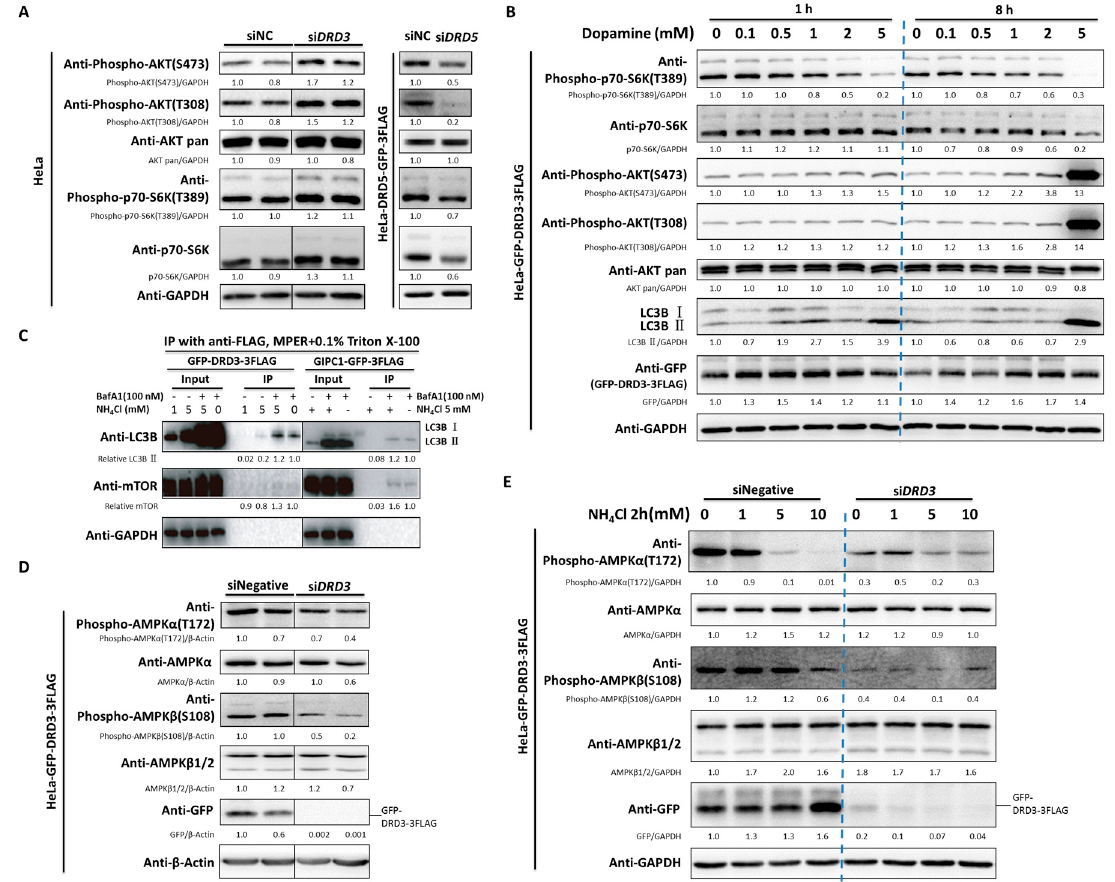
Figure 5. AKT (protein kinase B)-mTOR (mechanistic target of rapamycin) and AMPK (AMP-activated protein kinase) pathways are involved in DRD3-regulated autophagy. ( A ) DRD3 or DRD5 RNAi in HeLa wild type or HeLa cells stably expressing DRD5-GFP-3FLAG. ( B ) HeLa cells stably expressing GFP-DRD3-3FLAG were treated with increasing concentrations of dopamine for 1 h or 8 h. ( C ) Co-Immunoprecipitation using anti-FLAG in HeLa cells stably expressing GFP-DRD3-3FLAG or GIPC1-GFP-3FLAG treated with Baf A1 and/or NH 4 Cl, in the presence of additional 0.1% Triton X-100 in IP and washing buffers. ( D ) DRD3 RNAi in HeLa cells stably expressing GFP-DRD3-3FLAG decreases AMPK activity shown by AMPK α -T172 and β -S108. ( E ) DRD3 RNAi in HeLa cells stably expressing GFP-DRD3-3FLAG partially antagonizes the effect of ammonia-induced AMPK α -T172 and β -S108 inhibition. The blue dashed lines are used to distinguish different parts of the results for better visualization. Experiments were repeated at least three times and representative Western blots are shown. Densitometric analysis was performed and quantification results were labeled below the corresponding blots.